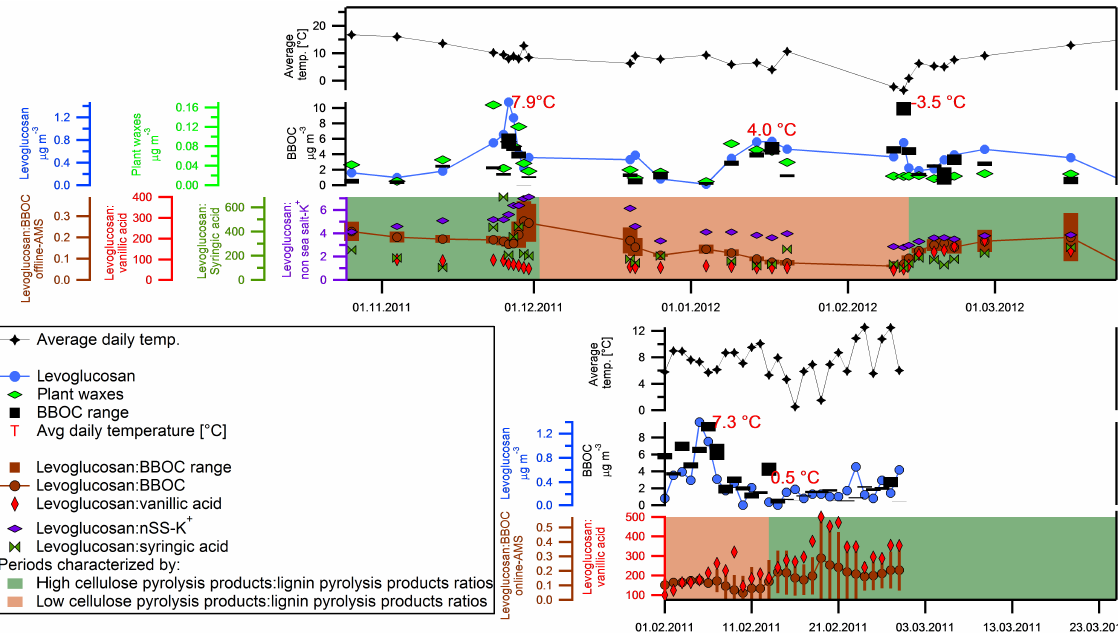
Figure 11. Online- and offline-AMS time-dependent levoglucosan:BBOC, levoglucosan:vanillic acid, levoglucosan:syringic acid, and levoglucosan:K + ratios. The plant wax concentrations were determined from GC-MS measurements of alkanes with an odd number of carbons (Li et al., 2010). As discussed in the main text the spike observed in late autumn could be related to incomplete green waste